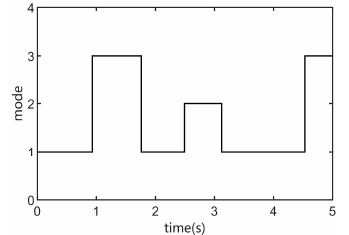
Figure 1. Semi-Markov jump modes.